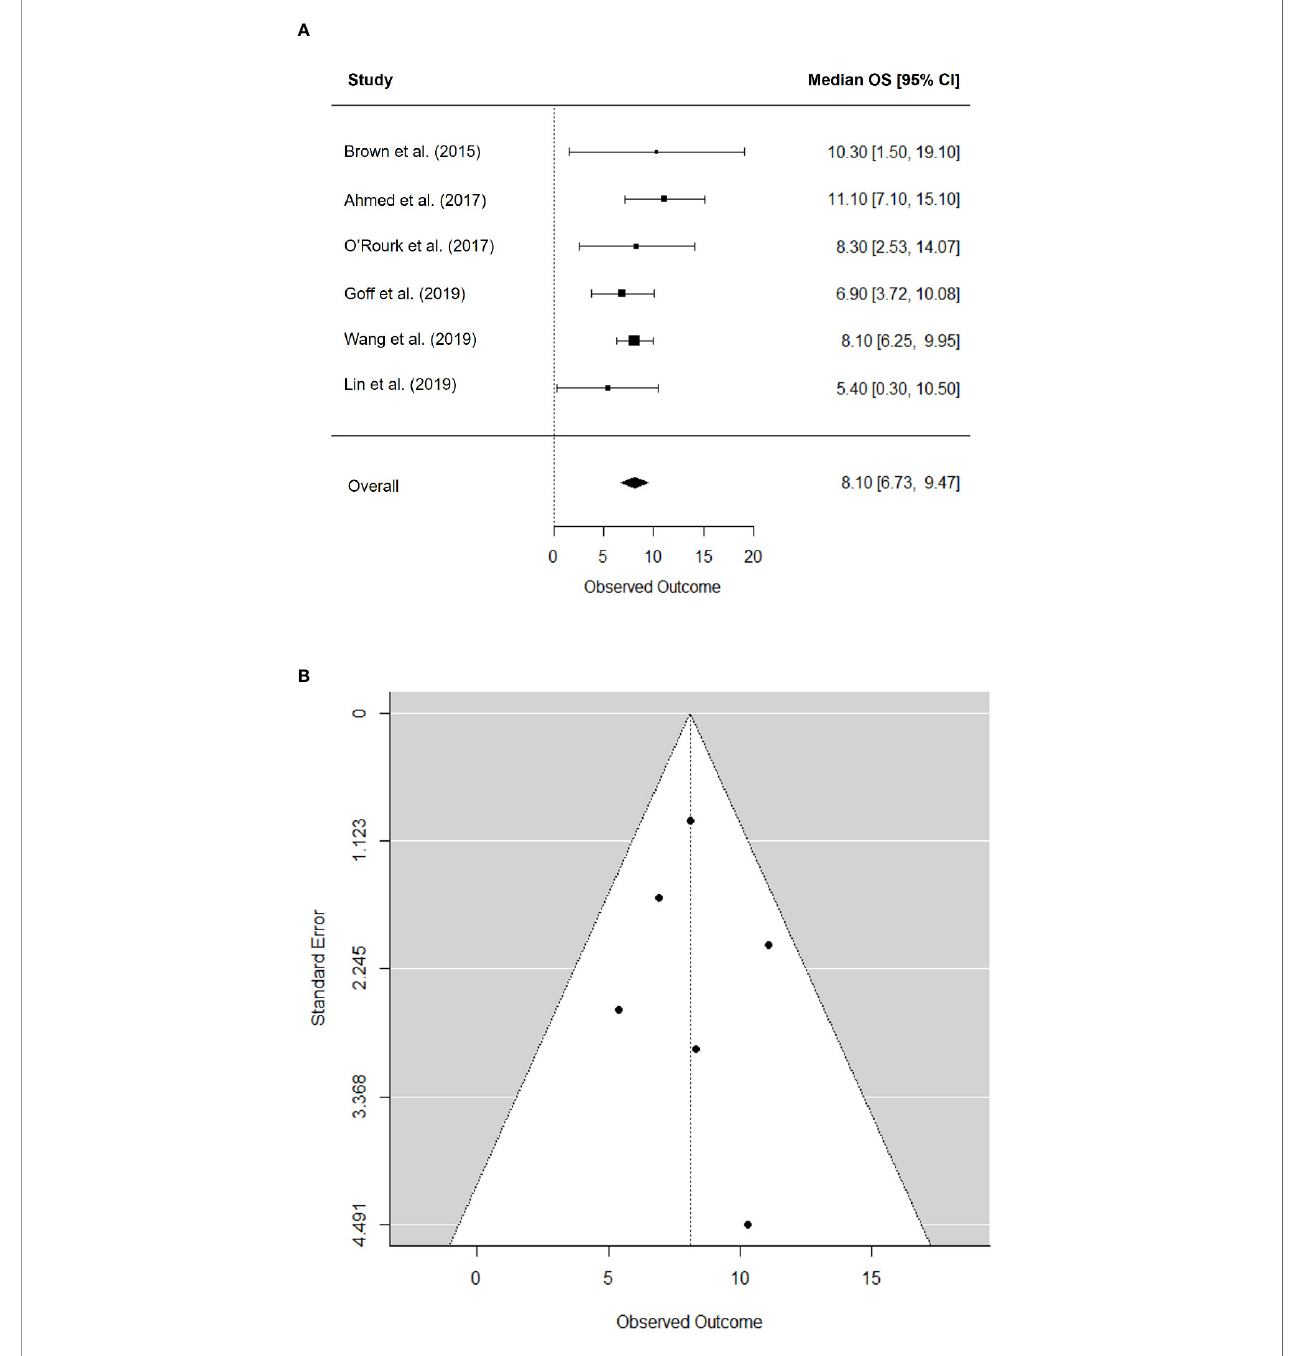
FIGURE 3 | Forest plot for median overall survival (A) and funnel plot of publication bias in median overall survival (B)